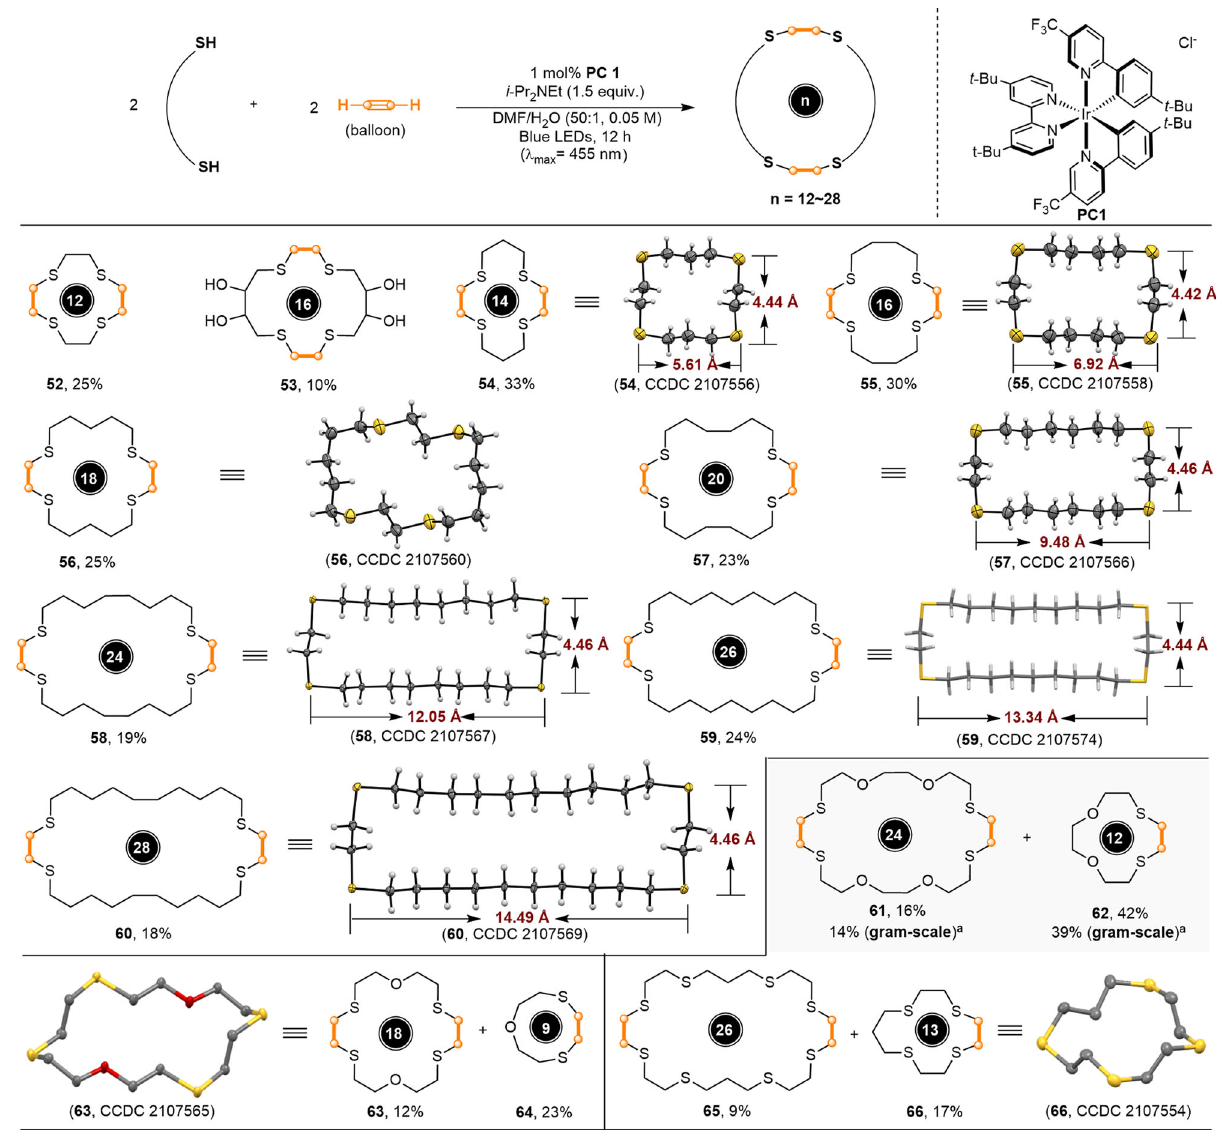
Fig. 3 | Substrate scope for synthesis of [2+2] and [1+1] patter-based macro- cycles. Reaction conditions: Disul fi de (0.25mmol), PC1 (2.5 μ mol, 1.0mol%) and a